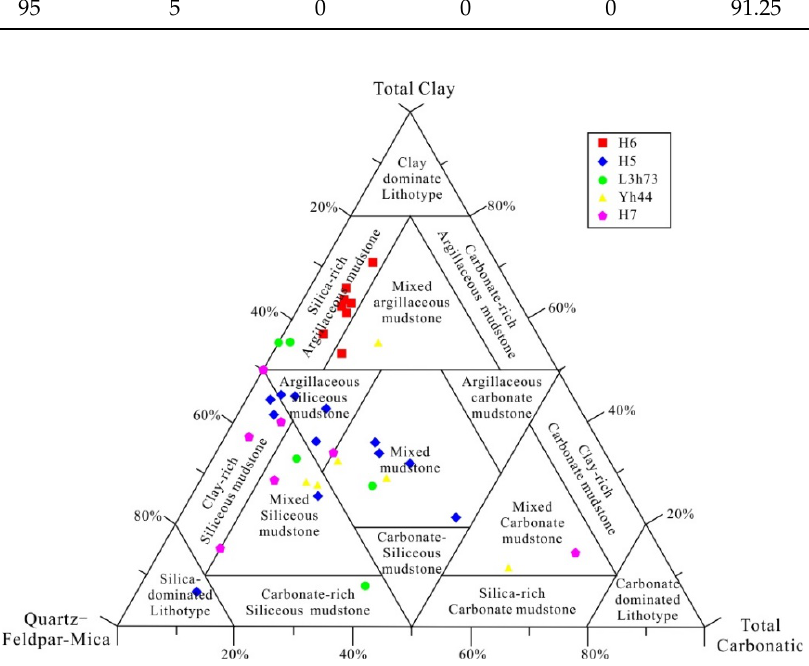
Figure 2. Shale facies division of the Longmaxi Formation in the study area (modified from [25]).